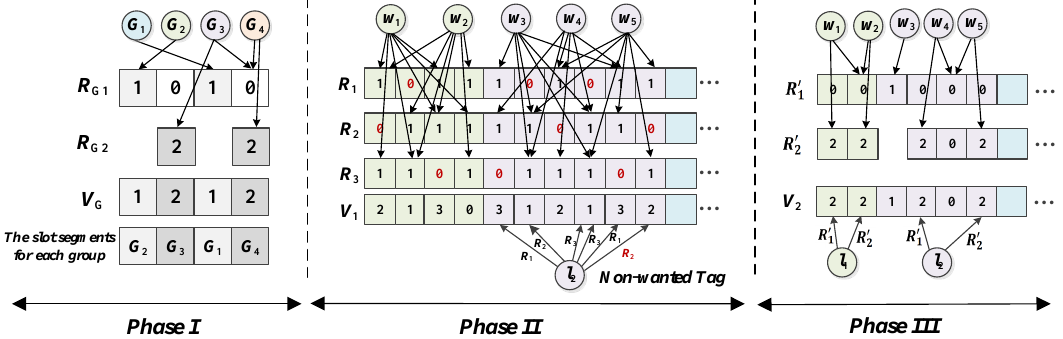
Figure 4. Illustration of the A-Search tag searching